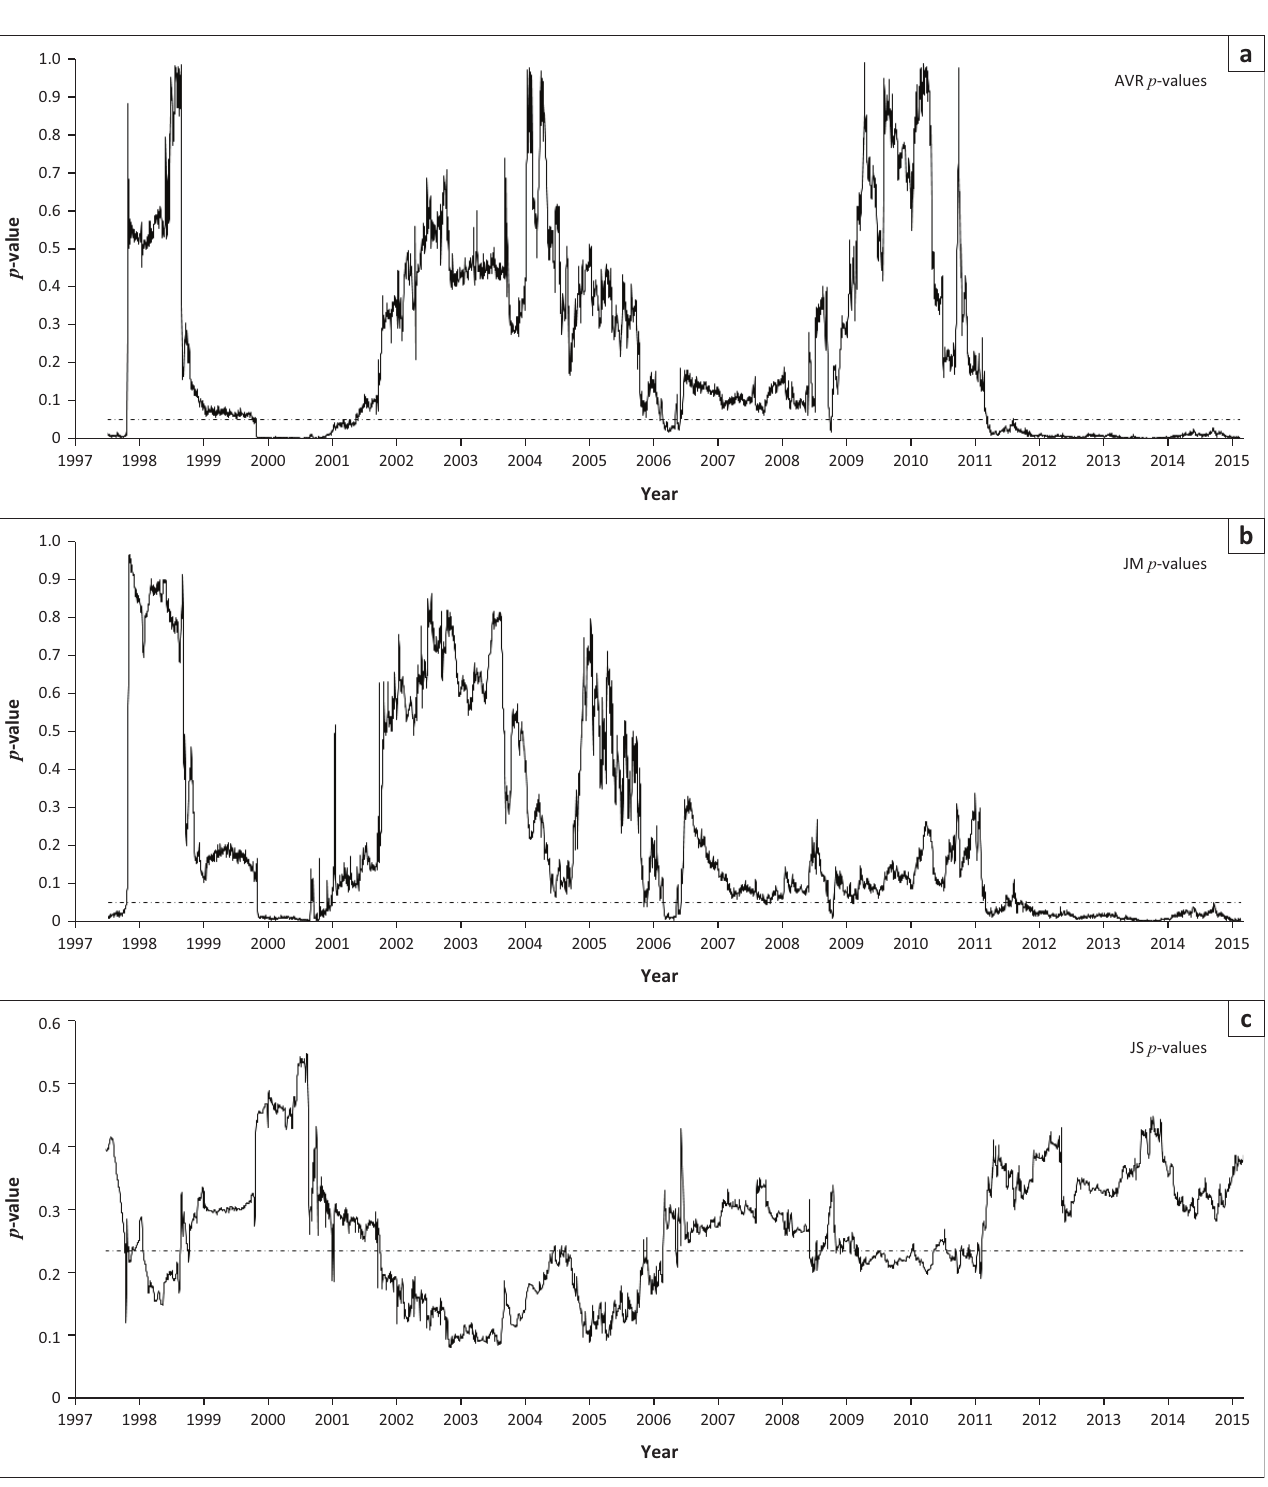
FIGURE 4: J580 – Financials index: (a) AVR p -values, (b) JM p -values, (c) JS p